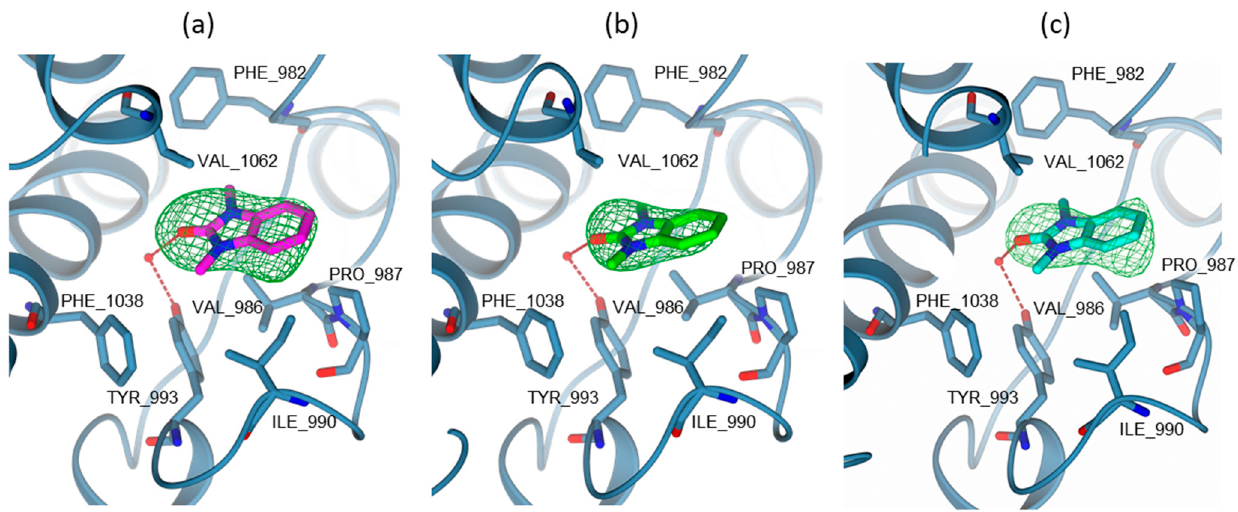
Figure 14. KAc binding site view of TRIM33 α PHD-BRD (steel blue cartoon and carbon atoms; residues in sticks) in complex with ( a ) 8 (PDB code: 8BD8—in sticks, magenta carbon atoms); ( b ) 9 (PDB code: 8BDY—in sticks, green carbon atoms); ( c ) 10 (PDB code: 8BD9—in sticks, cyan carbon atoms). In all figures, ligands are surrounded by the omit map (dark green mesh) contoured at 2.5 σ level. Water molecules are displayed as red spheres (arbitrary radius). Hydrogen bonds are represented as red dashed lines. Oxygen and nitrogen atoms are coloured red and blue, respectively.